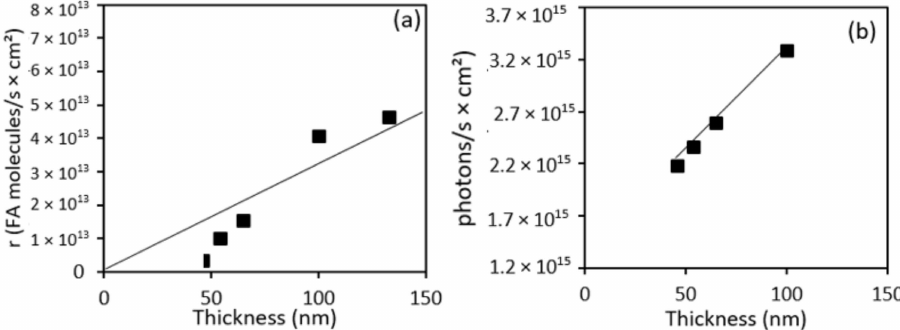
Figure 3. ( a ) FA disappearance rate as a function of the thickness of the unstructured TiO 2 film. ( b ) Photons absorbed as a function of the TiO 2